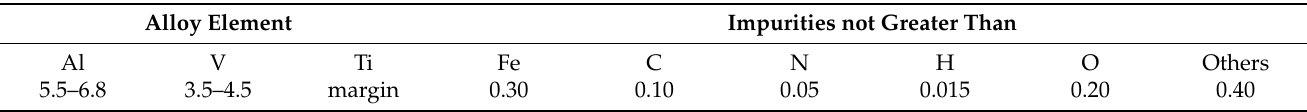
Table 1. Chemical composition of the TC4 titanium